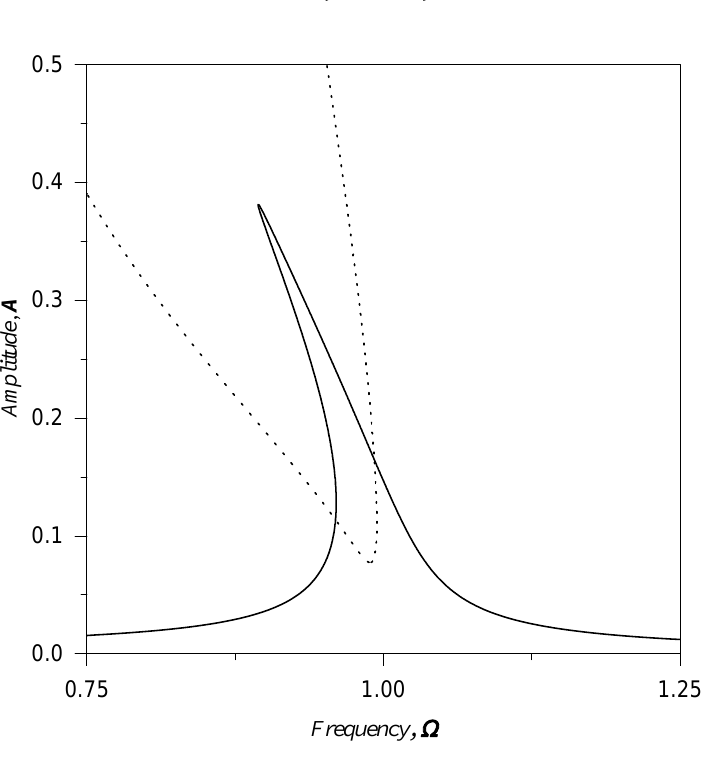
Fig. 5. Same as Fig. 4, but for the second